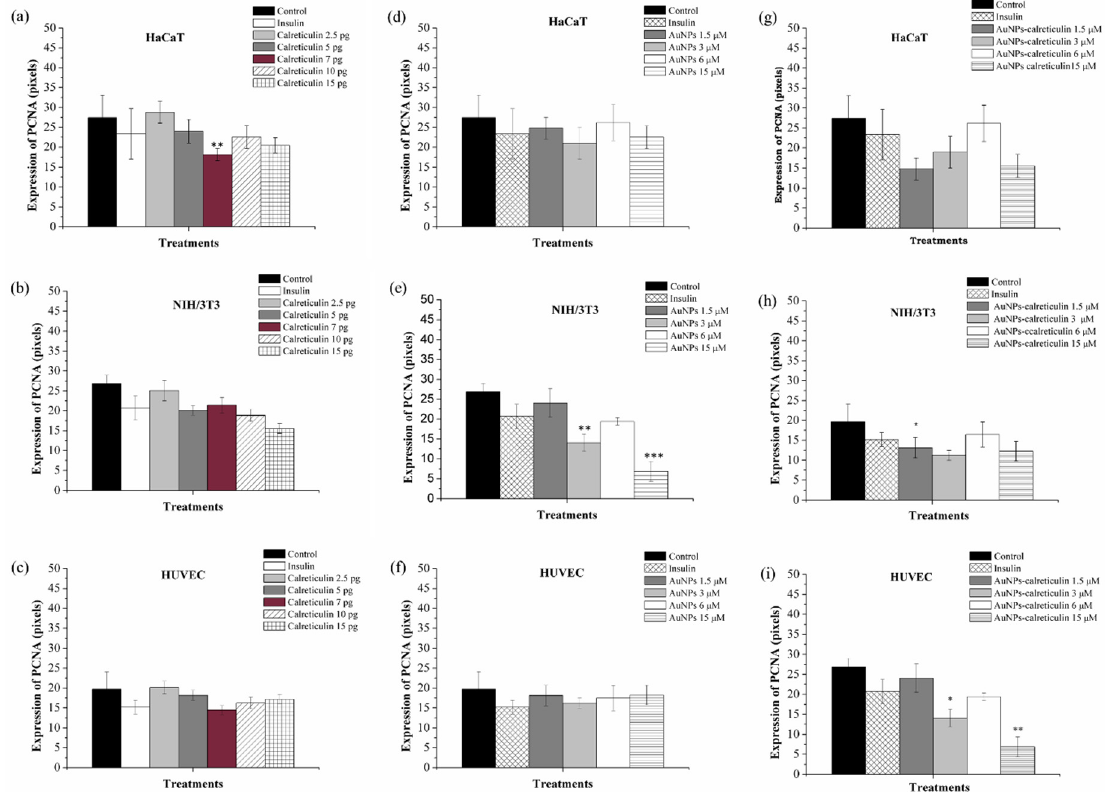
Figure 6. Intensity of expression of proliferating cell nuclear antigen (PCNA). Cells treated with calreticulin ( a – c ), AuNPs ( d – f ), and AuNPs–calreticulin ( g – i ). The expression of PCNA at day 3 was not affected with treatments used. Significant difference at * p < 0.05, ** p < 0.01 and *** p < 0.0001.